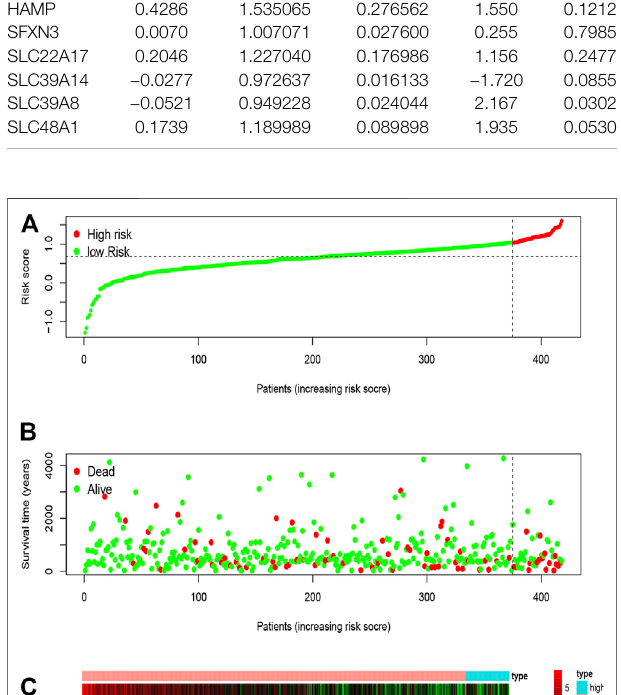
Frontiers in Cell and Developmental Biology |